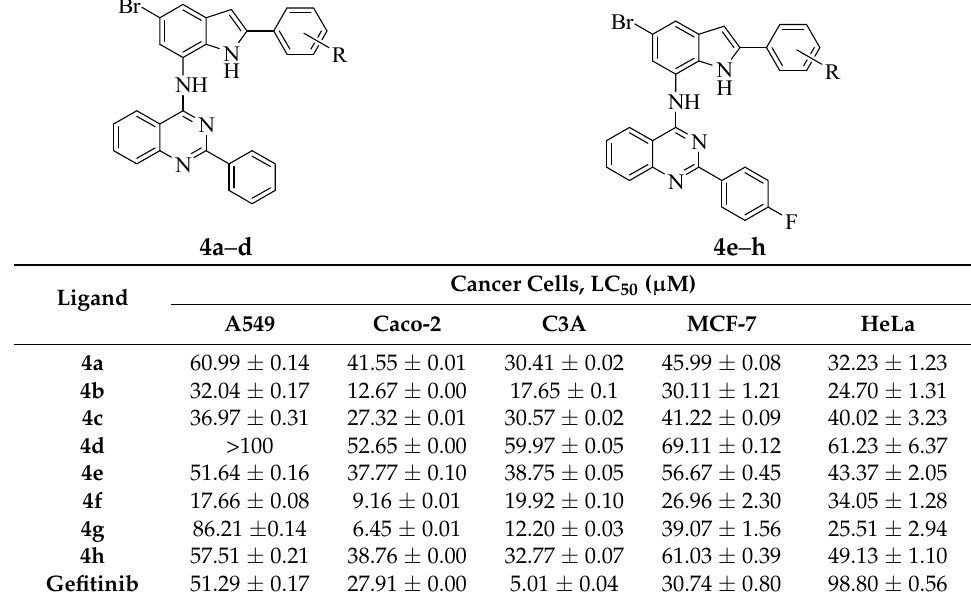
Table 2. Cytotoxic effects of 4a – h against the A549, Caco-2, C3A, MCF-7, and HeLa cell lines.